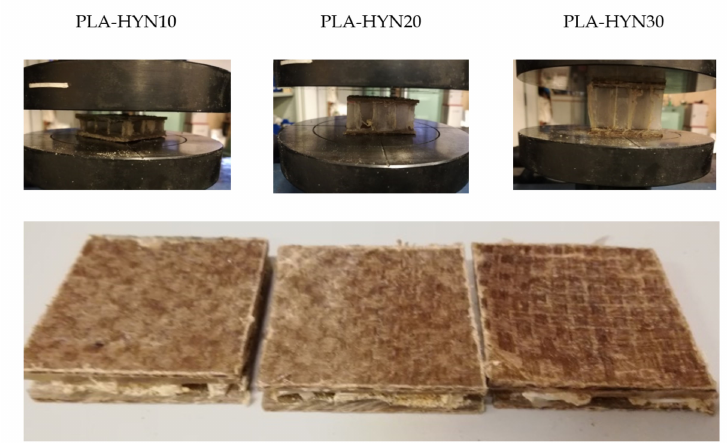
Figure 5. Pictures of the flatwise compression test of composite sandwiches with PLA honeycomb cores with different thicknesses: The left column shows the initial elastic stage; the right column shows the image after the failure.